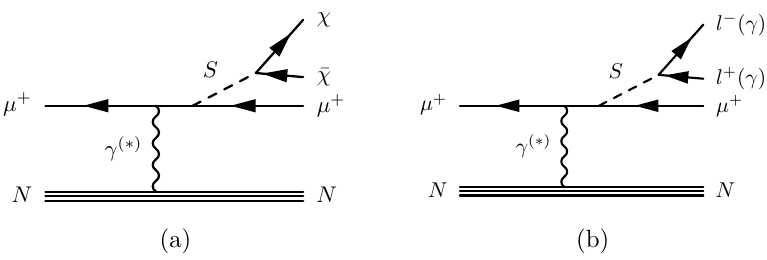
Figure 2. Diagrams contributing to the signal in a muon missing momentum search for dark